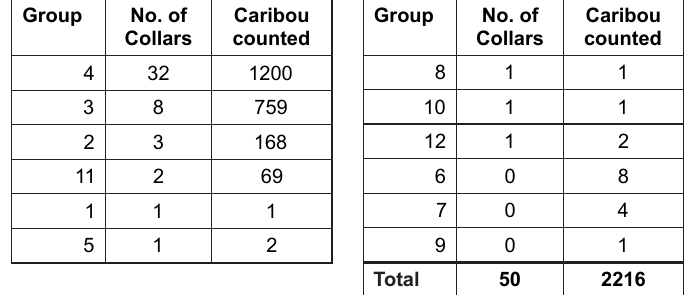
Table 33. Summary of field data for the 2015 Cape Bathurst survey.